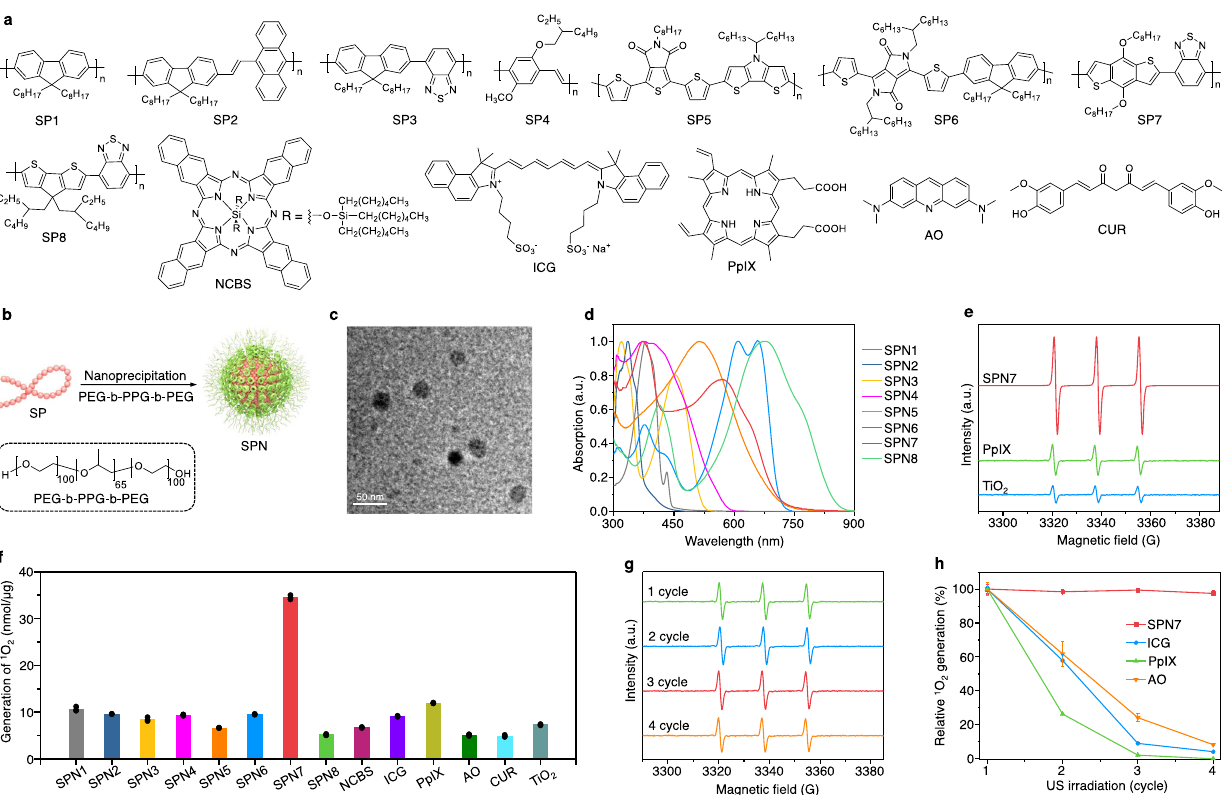
Fig. 2 Screening of SPNs for sonodynamic therapy. a Chemical structures of SPs and small molecular sonosensitizers. b Schematic illustration of the synthesis of SPNs via nanoprecipitation. c Representative TEM image of SPN7. The experiment was repeated independently three times with similar results. d UV – vis absorption spectra of SPNs in 1× phosphate-buffered saline (PBS) solution (pH = 7.4). e ESR spectra of SPN7, PpIX and TiO 2 nanoparticles (20 µ g/mL) after US irradiation using TEMP as the trap. f Quanti fi cation of sonodynamic 1 O 2 generation for each sample (20 µ g/mL) ( n = 3). g ESR spectra of SPN7 (20 µ g/mL) after 1, 2, 3, and 4 cycles of US irradiation with TEMP as the trap. h Relative 1 O 2 generation for SPN7, ICG, PpIX and AO (20 µ g/mL) after different cycles of US irradiation ( n = 3). US-irradiation conditions: 1.0 MHz, 1.2 W/cm 2 , 50% duty cycle, 5 min for each cycle. Data are presented as mean values ± SD. Source data are provided as a Source Data fi